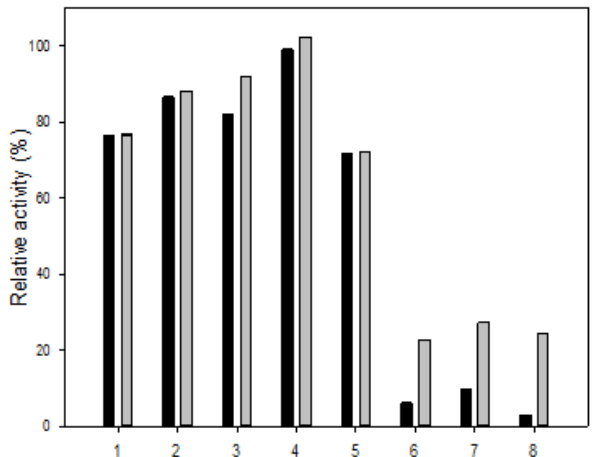
Figure 5. Cation tolerance of R5-SazCA and R5-SazCA-SP. 1: NH 4+ ; 2: K + ; 3: Na + ; 4: Mg 2+ ; 5: Mn 2+ ; 6: Zn 2+ ; 7: Cu 2+ ; and 8: Fe 2+ . Black bar: R5-SazCA; gray bar: R5-SazCA-SP. The activities before incubation with cations were set as 100%. The enzyme solution or suspension was incubated with the cation at a final concentration of 5 mM for 30 min followed by measuring its CO 2 hydratase activity.